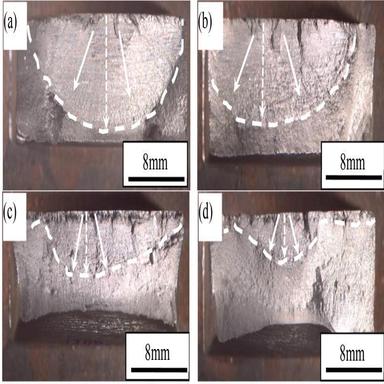
Macro fractures (a) 100 MPa (b) 120 MPa (c) 140 MPa (d) 160 MPa.